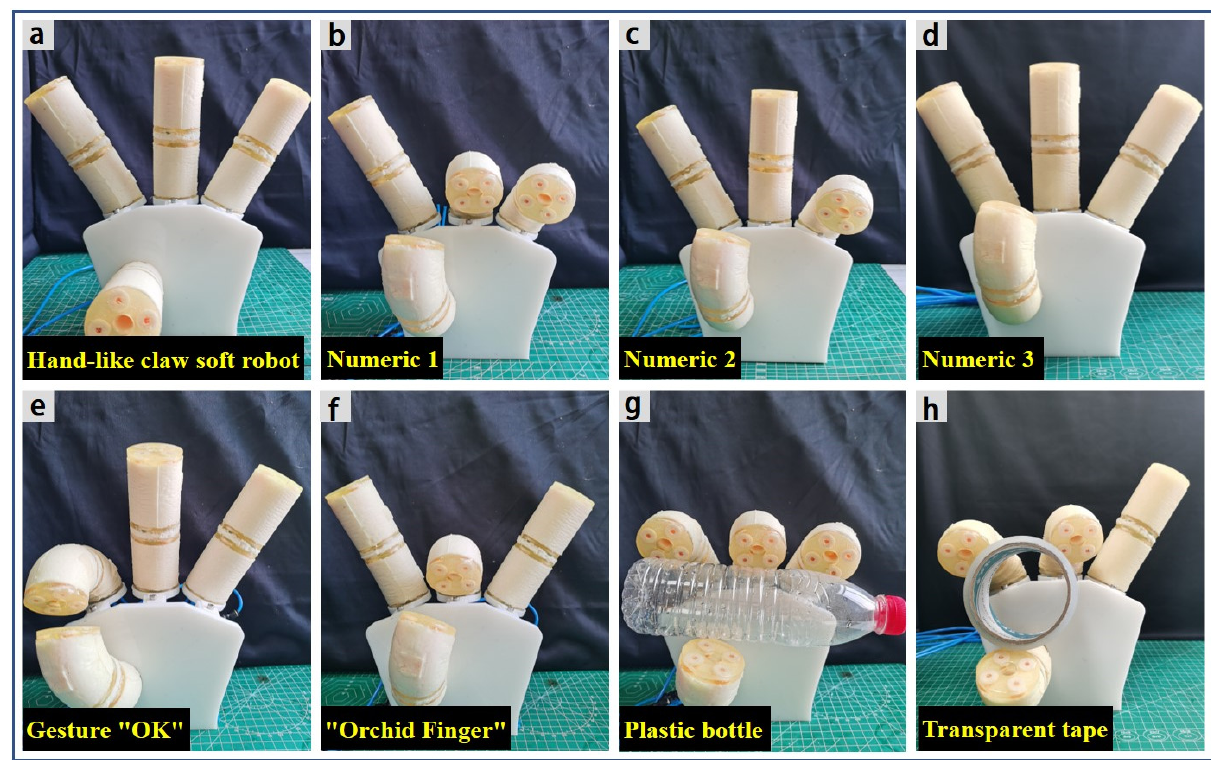
Figure 13. ( a ) Claw-like soft robot; ( b – d ) gestures for numbers 1–3; ( e , f ) gestures for “okay” and “orchid finger”; ( g , h ) gripping a plastic bottle and transparent tape.